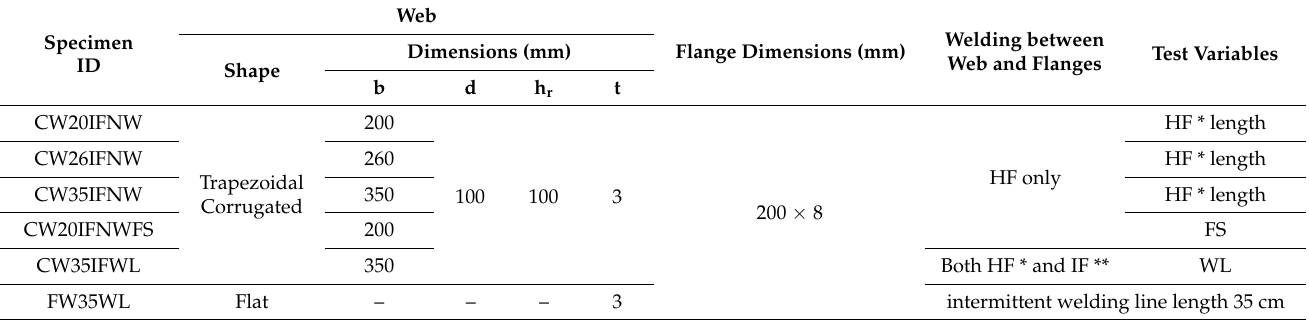
Table 1. Test matrix and specimen